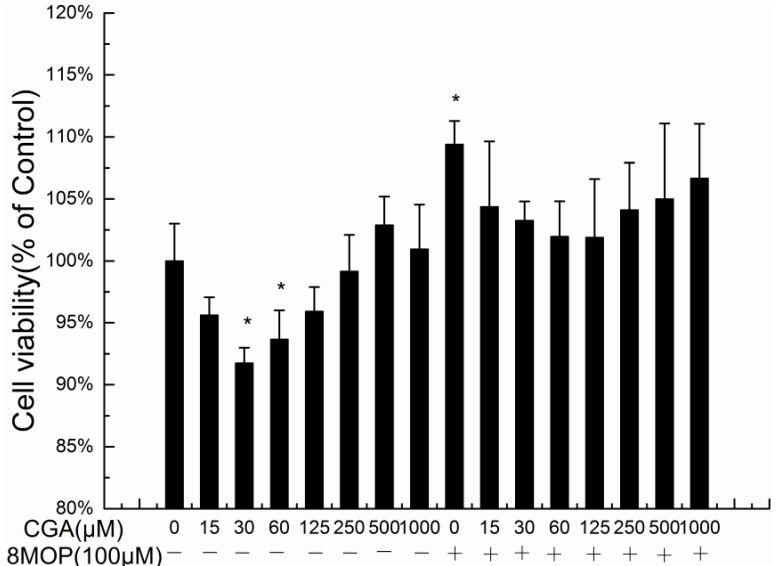
Figure 2. The effects of CGA on the cell proliferation of B16 melanoma cells and 8-MOP-treated B16 melanoma cells. Each value represents the mean ± SE ( n = 3). * p < 0.05, compared with the